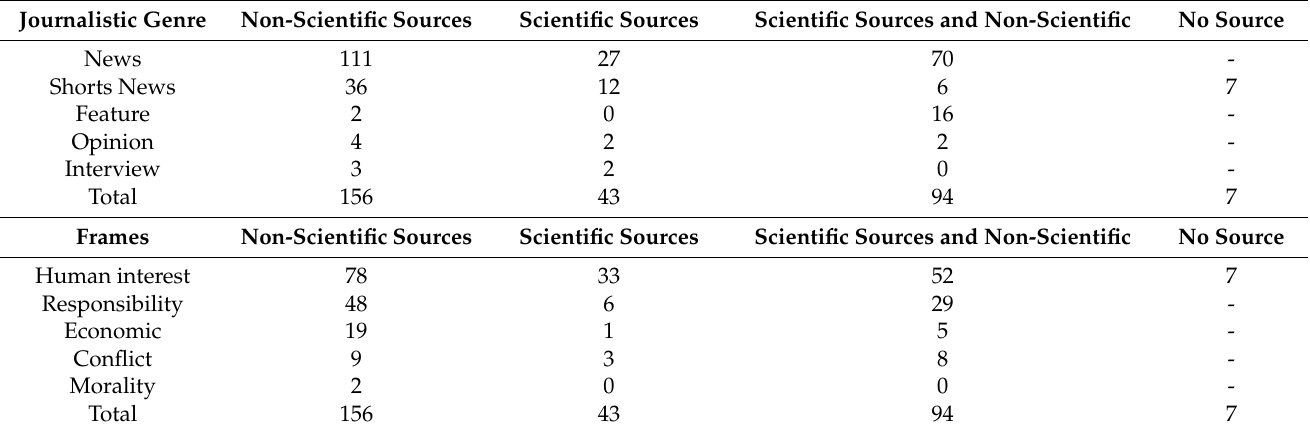
Table 3. Frequency of articles by sources, journalistic genre and